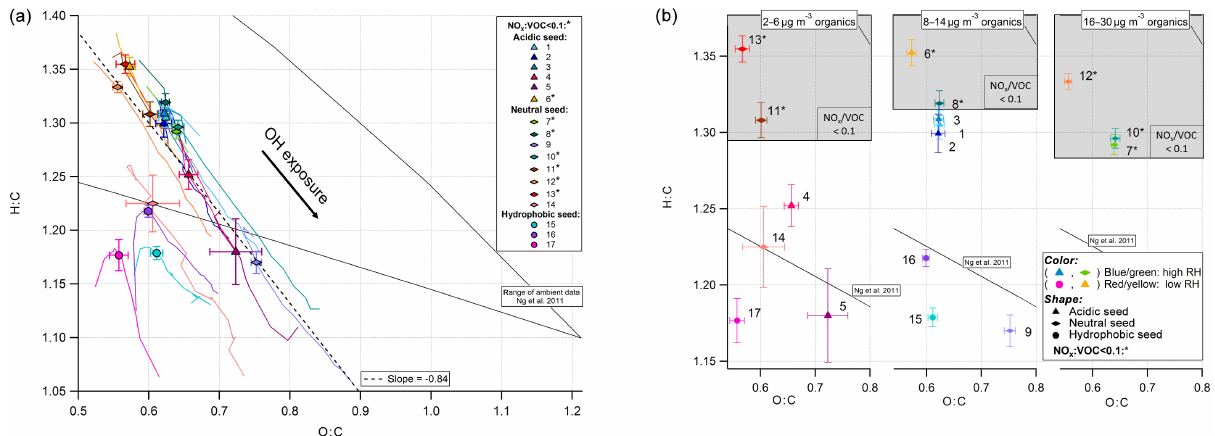
Figure 3. Van Krevelen diagrams: mean (and 1SD measurement variability) H:C versus O:C at OH exposure (2.0 ± 0.5) × 10 7 cm − 3 h (symbols). Symbol colours indicate RH, symbol shapes the seed composition and the asterisk low NO x experiments. (a) The dashed line represents the (least orthogonal distance) fitted slope of experiments (1–14) with inorganic seed: − 0.84. The triangular-shaped solid lines represent the range of ambient SOA (Ng et al., 2011a); 1h averages of H : C versus O:C (for OH exposure >2 × 10 6 cm − 3 h) are given by the coloured lines. Experiments 15–17 show the influence of organic seed compounds (data shown from suspended organic mass >0.3µgm − 3 ) . (b) The data were split into three groups according to their wall-loss-corrected organic mass concentrations to exclude concentration effects (left panel: 2–6µgm − 3 ; middle panel: 8–14µgm − 3 ; right panel: 16–30µgm − 3 ) . The grey shaded areas include all low NO x